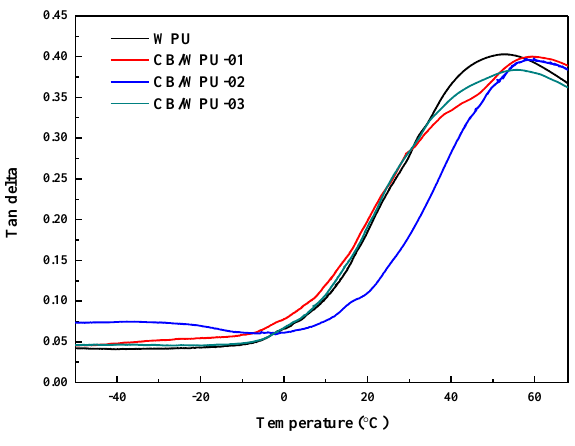
Figure 5. DMA Tan δ curves of the CB / WPUs.